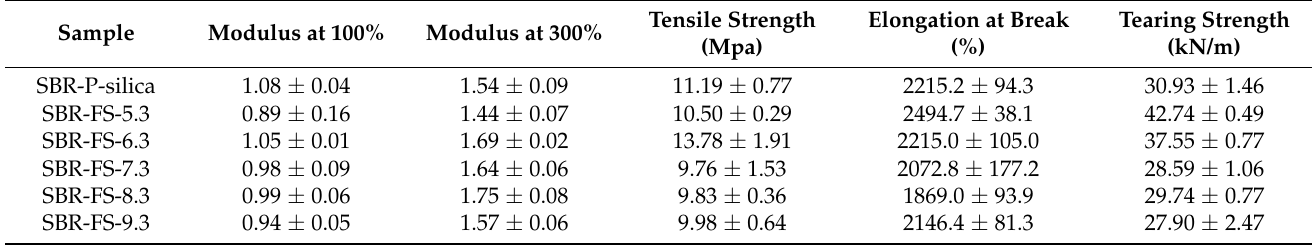
Figure 5. Mechanical properties of the SBR rubber filled with P-silica and FS-SiO 2 : ( a ) modulus at 100% and 300%, ( b ) tensile strength and elongation at break. Table 4. Mechanical properties of the SBR rubber composites with P-silica and FS-SiO 2 .